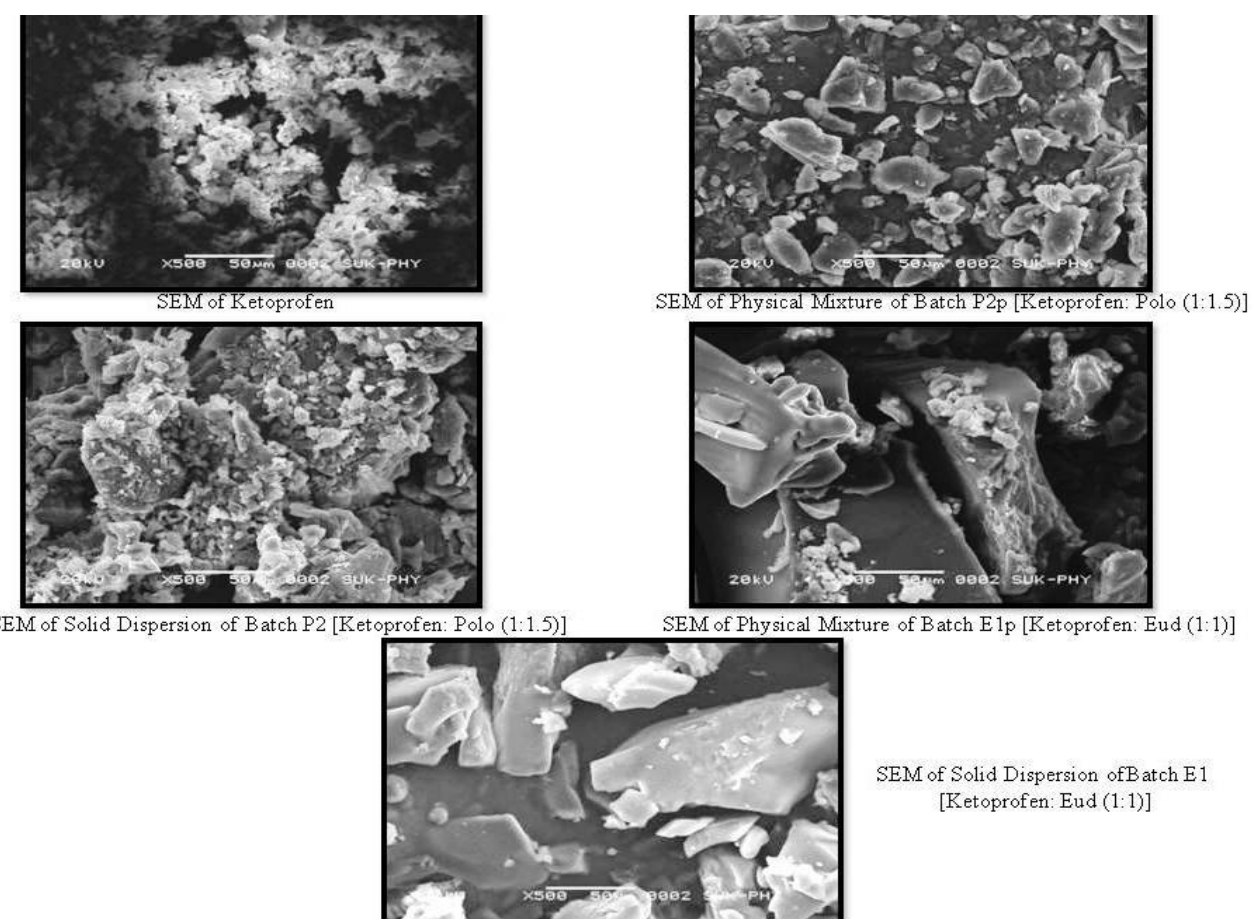
FIGURE 11 - SEMs of Ketoprofen, Physical mixtures and Solid